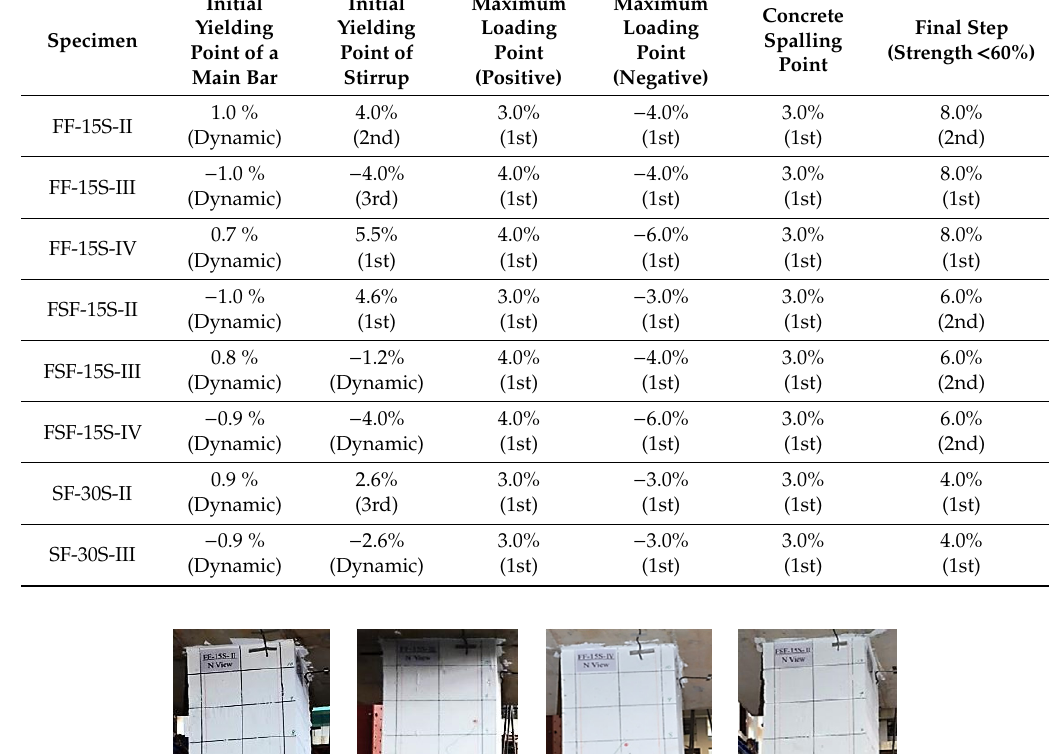
Table 3. Performance points of each specimen under di ff erent loading scheme.